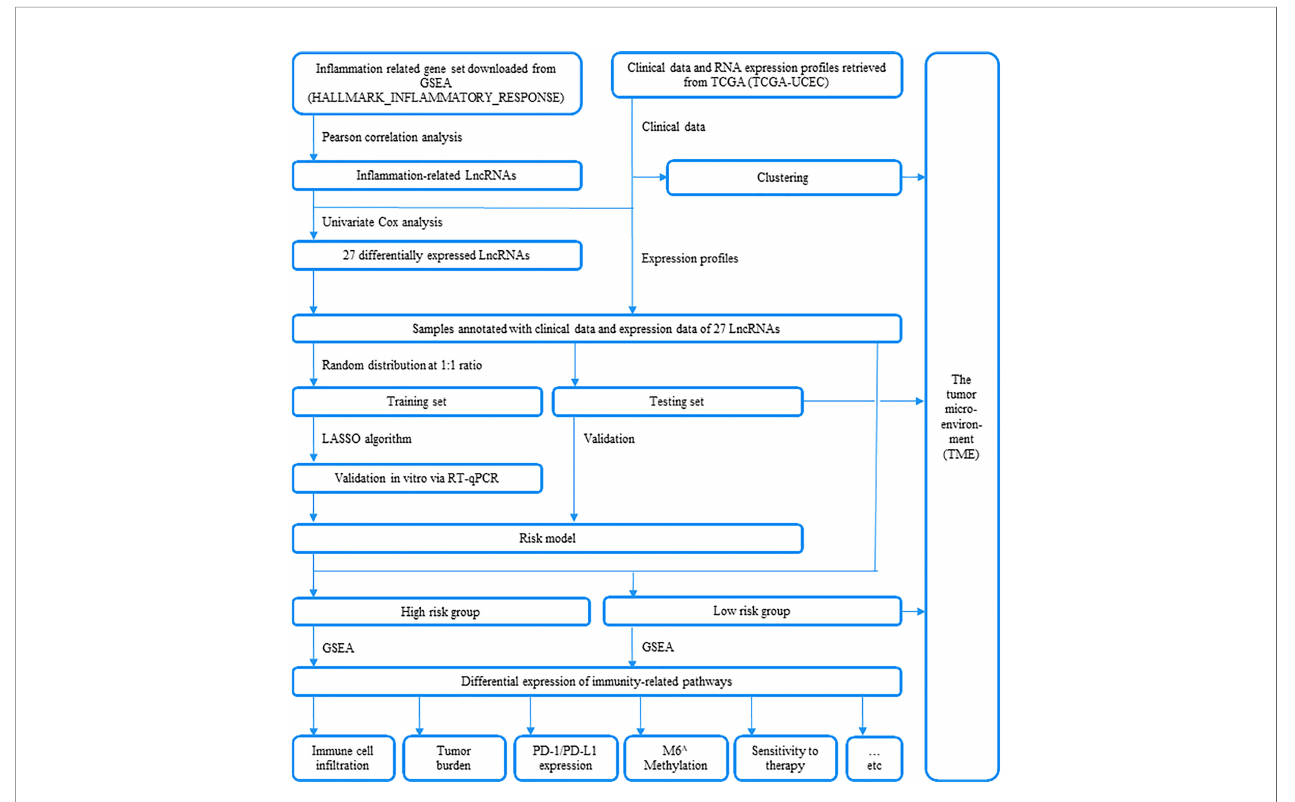
FIGURE 1 | An outline of this research is depicted in this